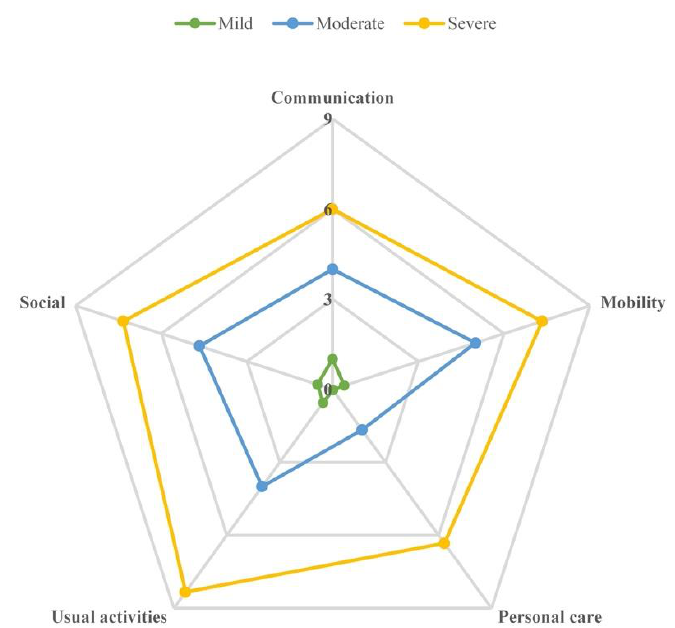
Figure 2. Radar plot of the mean severity of five Long COVID-related functional difficulties